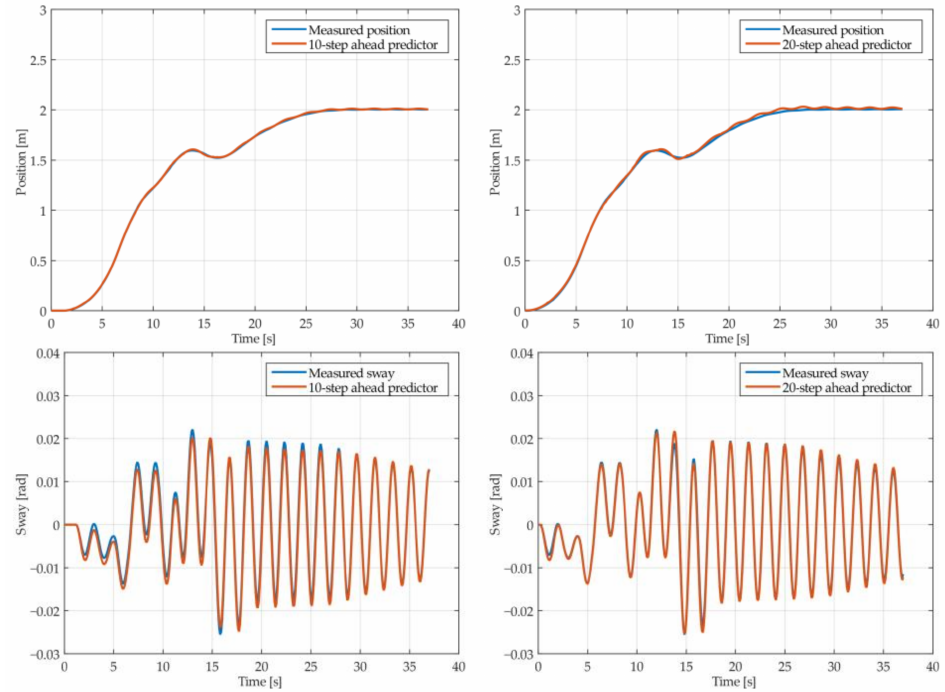
Figure 7. The 10- and 20-step ahead prediction with the MGGP model of the simulated crane position and payload sway with 1.3 m rope length and 40 kg payload mass.